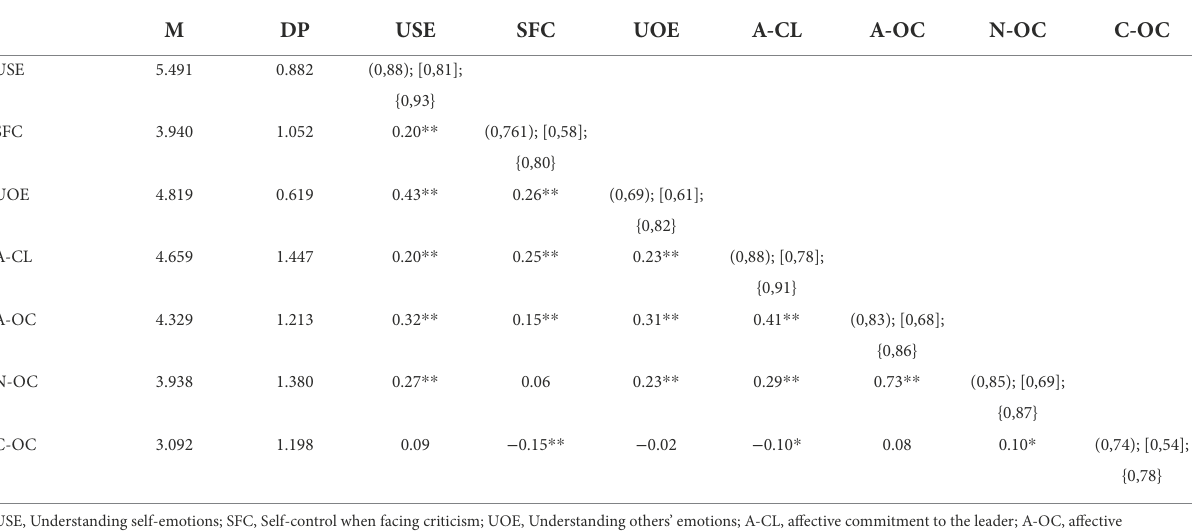
TABLE 2 Goodness of fit index of the relation between emotional awareness and organizational commitment.